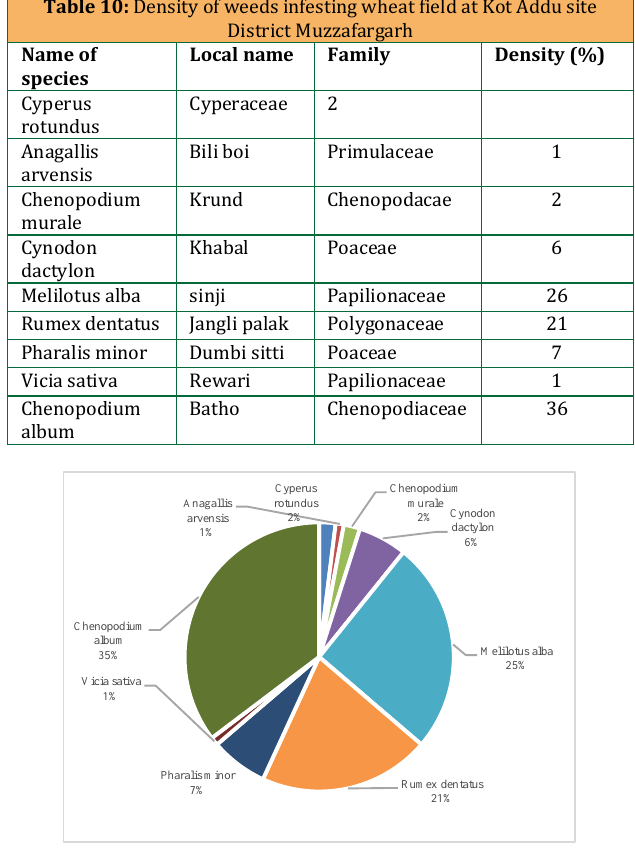
Figure 10: Density of weed infesting in wheat field Kot Addu District